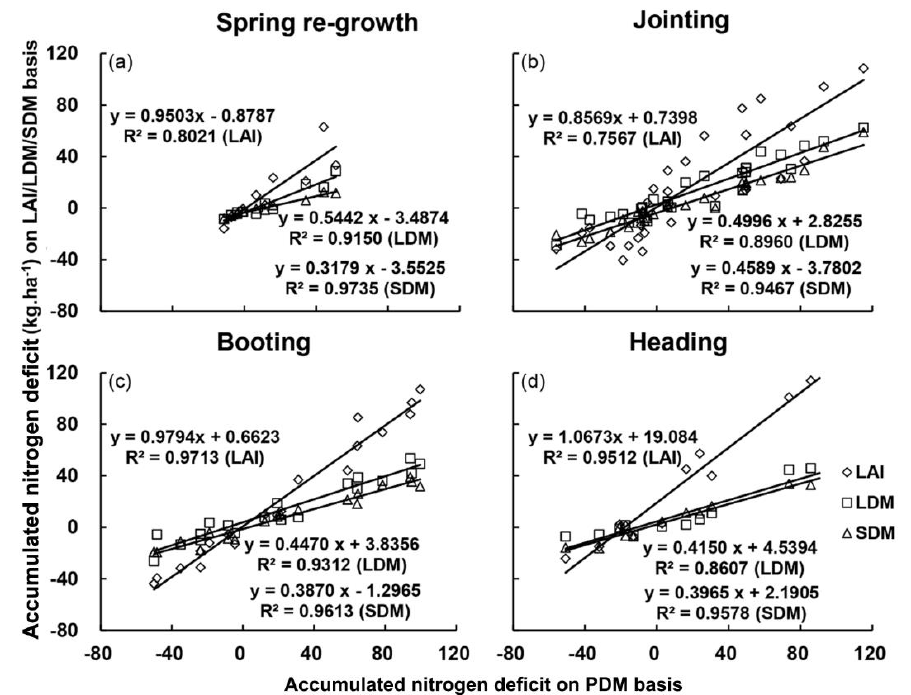
Figure 3. The relationships about accumulated nitrogen deficit (AND, kg ha −1 ) between plant dry matter (PDM) and leaf area index, leaf dry matter, and stem dry matter based at different growth stages ( a − d means relationship between PDM basis AND and other indicators based NNI in different growth stages).